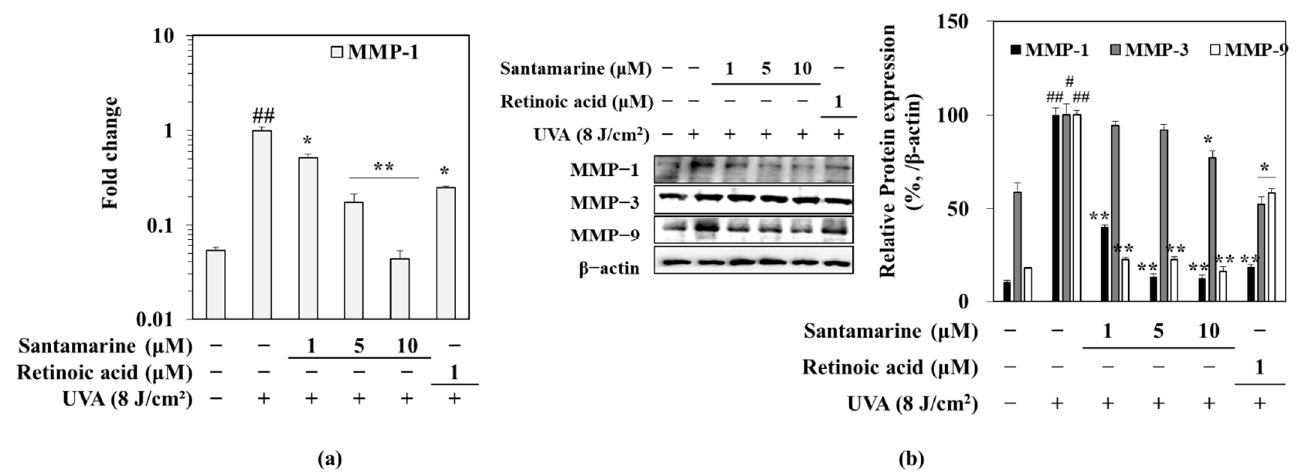
Figure 4. Effect of santamarine on the mRNA expression of MMP-1 ( a ) and the protein levels of MMP-1, MMP-3 and MMP-9 ( b ) analyzed by RT-qPCR and Western blot, respectively. UVA-irradiated (8 J/cm 2 ) HDFs were treated with santamarine for 24 h and the harvested cells were used to measure the MMP levels. β -actin was used as a loading control. Values are means ± SD ( n = 3). * p < 0.05 and ** p < 0.01 vs. UVA-irradiated untreated control. # p < 0.05 and ## p < 0.01 vs. non-irradiated control. Retinoic acid was used positive control.